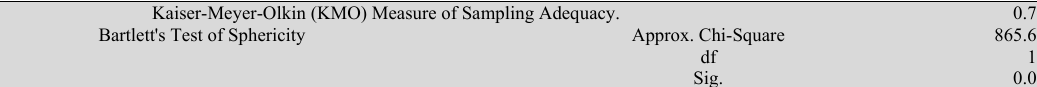
KMO and Bartlett's Test Kaiser-Meyer-Olkin (KMO) Measure of Sampling Adequacy.